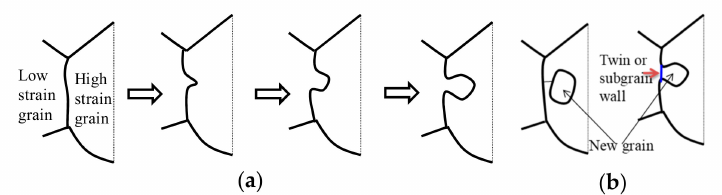
Figure 12. The development of DRX grains in the studied superalloy: ( a ) bulging nucleation due to grain boundary migration and ( b ) bulge separated from parent grain due to the formation of annealing twins or a bridging subgrains